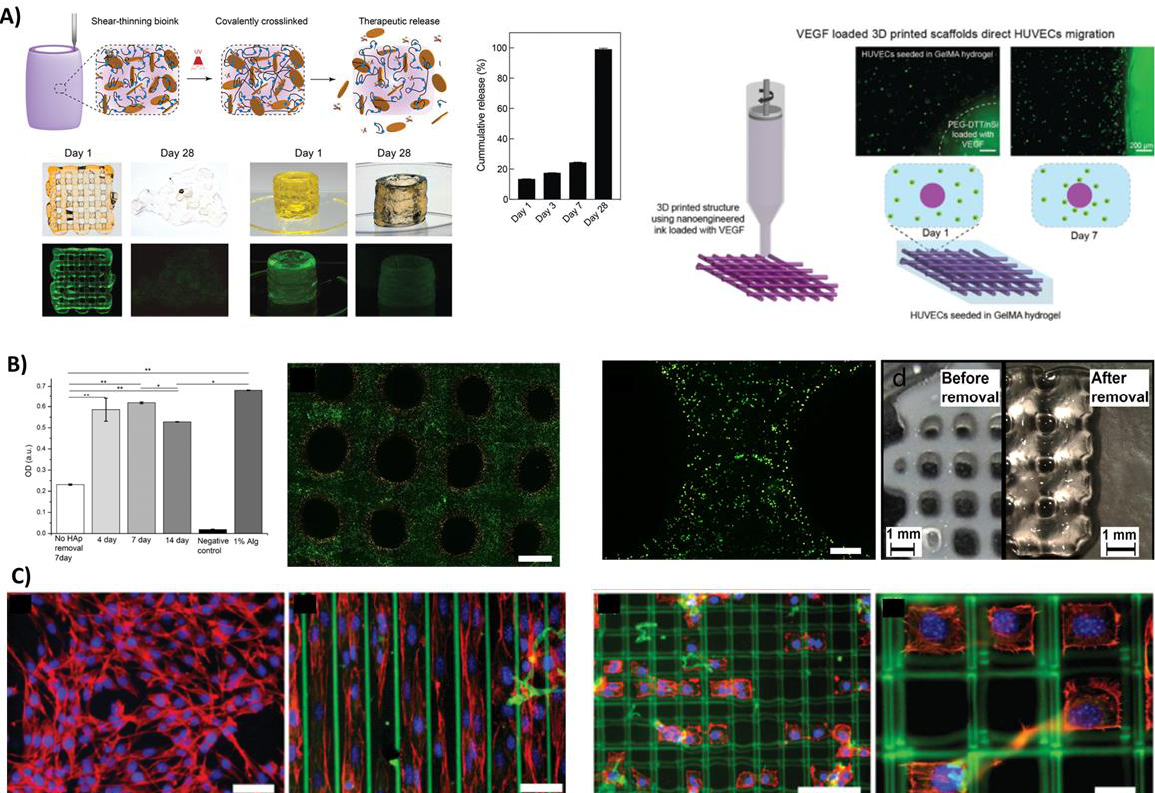
Figure 3. Key examples of synthetic materials used as bioinks and biomaterial-inks. By tuning the function of degradable PEG-based bioinks and the biofabrication of high surface area structures using extrusion-based printing technologies and UV crosslinking, Peak et al. prolonged the delivery of VEGF for up to 28 days to direct the migration of HUVECs encapsulated in surrounding GelMA hydrogels after 7 days of culture ( A ). Change the format as follows: Reprinted with permission from ref. [63]. Copyright 2019 John Wiley and Sons. PNIPAAM-based bioinks printed with extrusion-based technologies show better chondrocyte viability after washing away residual pNIPAAM, with increasing cell death observed around the pores, * p < 0.05 and ** p < 0.001 ( B ). Change the format as follows: Reprinted with permission from ref [70].